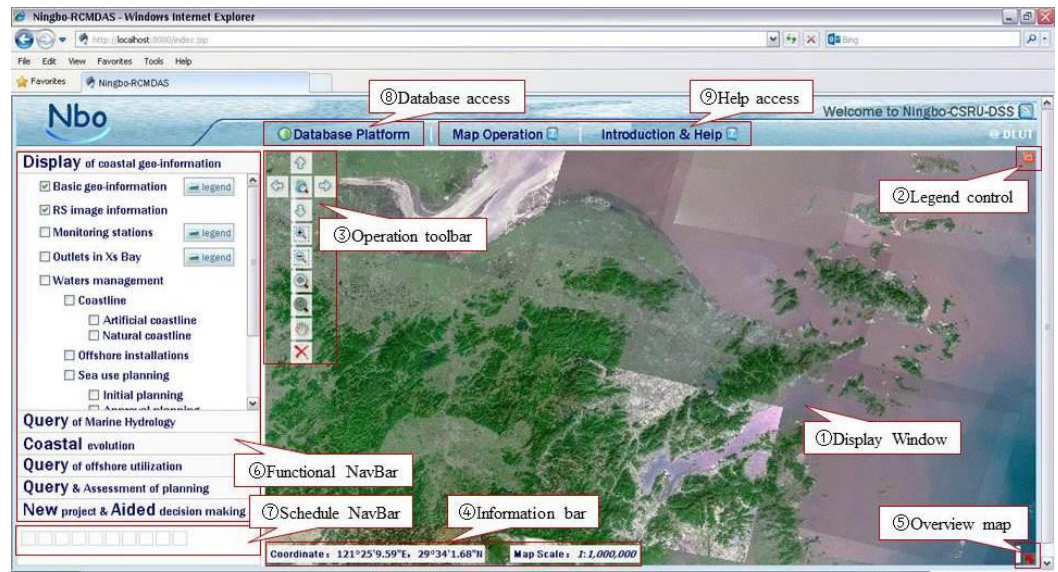
Figure 6. Main webpage of Ningbo-CSRU-DSS on a browser.